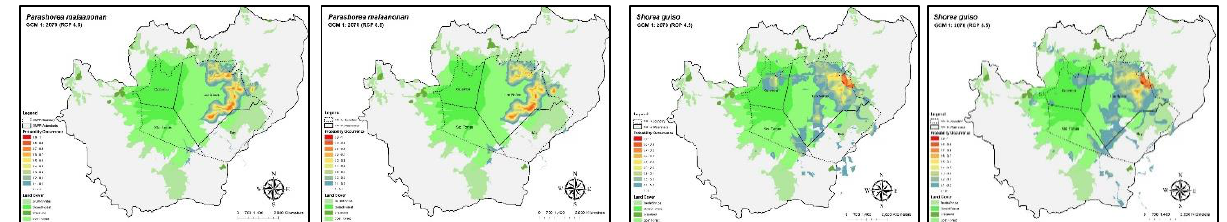
Figure 6. Predicted distribution of Parashorea malaanonan (L) and Shorea guiso (R) for GCM-1 by year 2050 under RCP 4.5 and RCP 8.5.